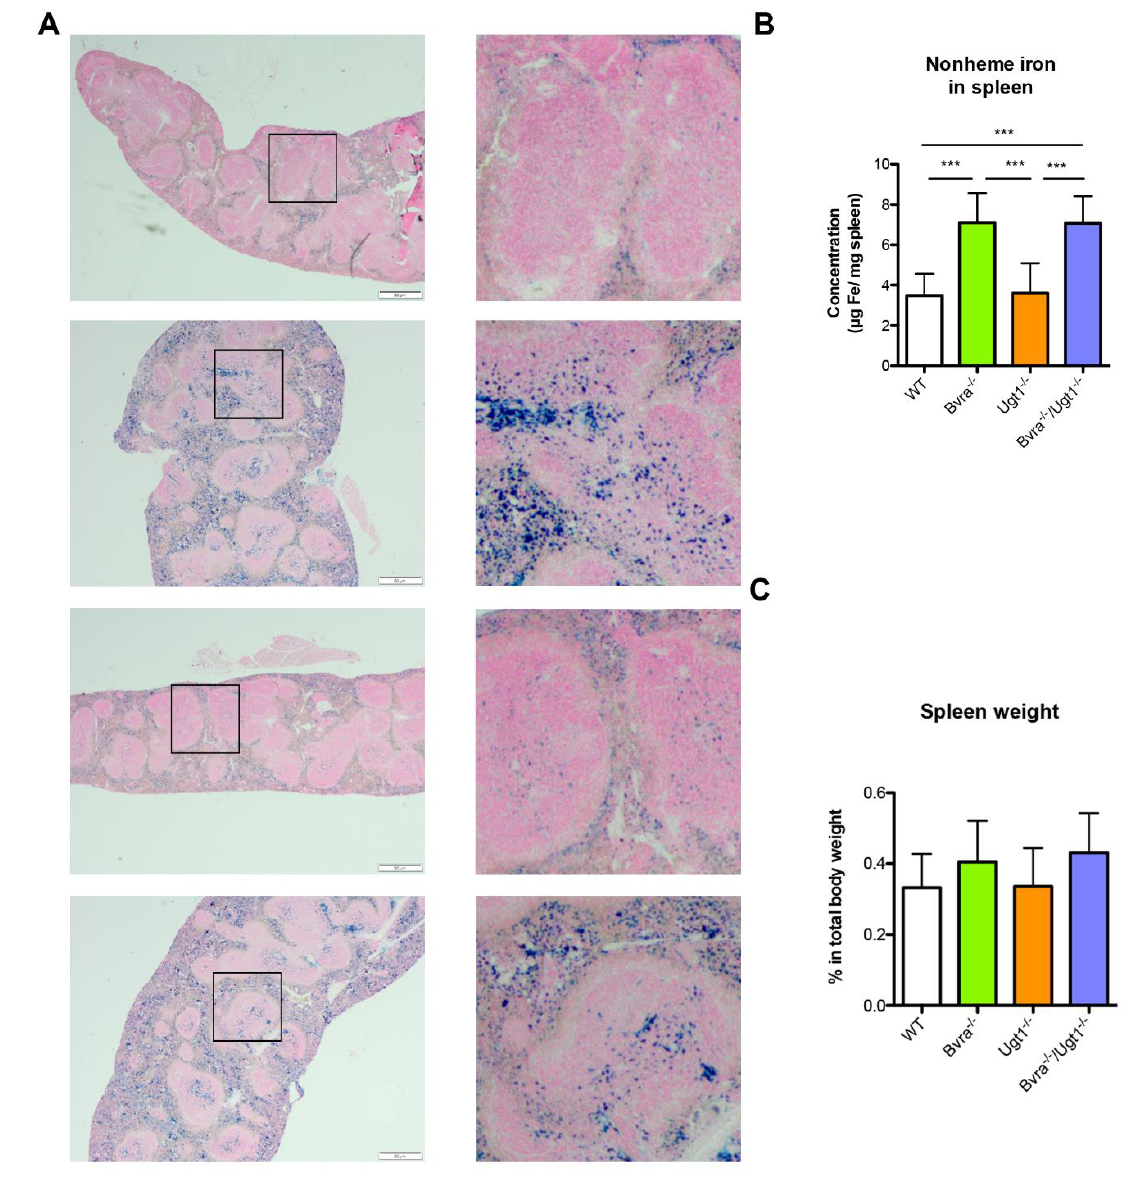
Figure 5. Iron accumulation in spleen from Bvra −/− and Bvra −/− Ugt1 −/− 9-months-old mice. ( A ) Representative images of Prussian blue staining revealed iron deposition in the spleen of 9-months-old Bvra −/− and Bvra −/− Ugt1 −/− mice. The boxed areas are shown at higher magnification in the right hand side of the panel. Scale bar 50 μm; ( B ) quantification of non-heme iron extracted from the spleen. One-way ANOVA, p ≤ 0.0001, F = 22.29; Bonferroni tests: ***, p ≤ 0.001; WT vs. Bvra −/− Ugt1 −/− : p ≤ 0.001; ( C ) spleen weight of 9-month-old mice, normalized by body weight. One-way ANOVA, p = 0.1145, F = 2.118, ns.